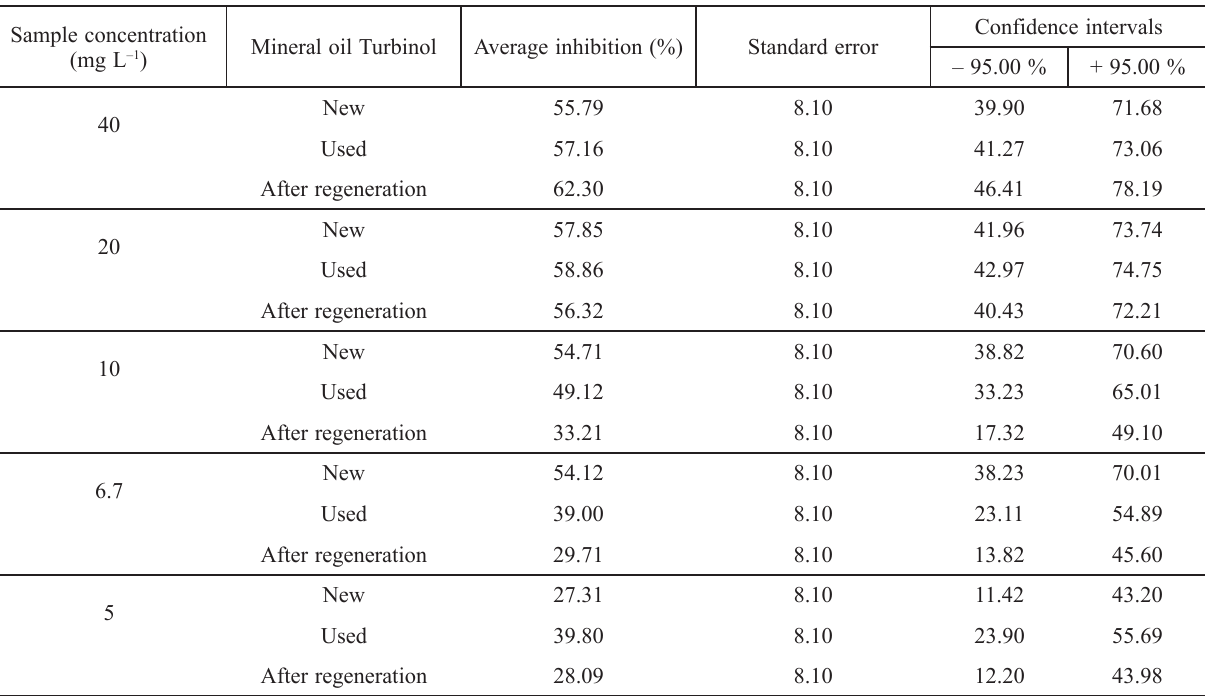
Table 6 – Basic statistical characteristics of test results of growth inhibition of Sinapis alba root Sample concentration (mg L –1 )